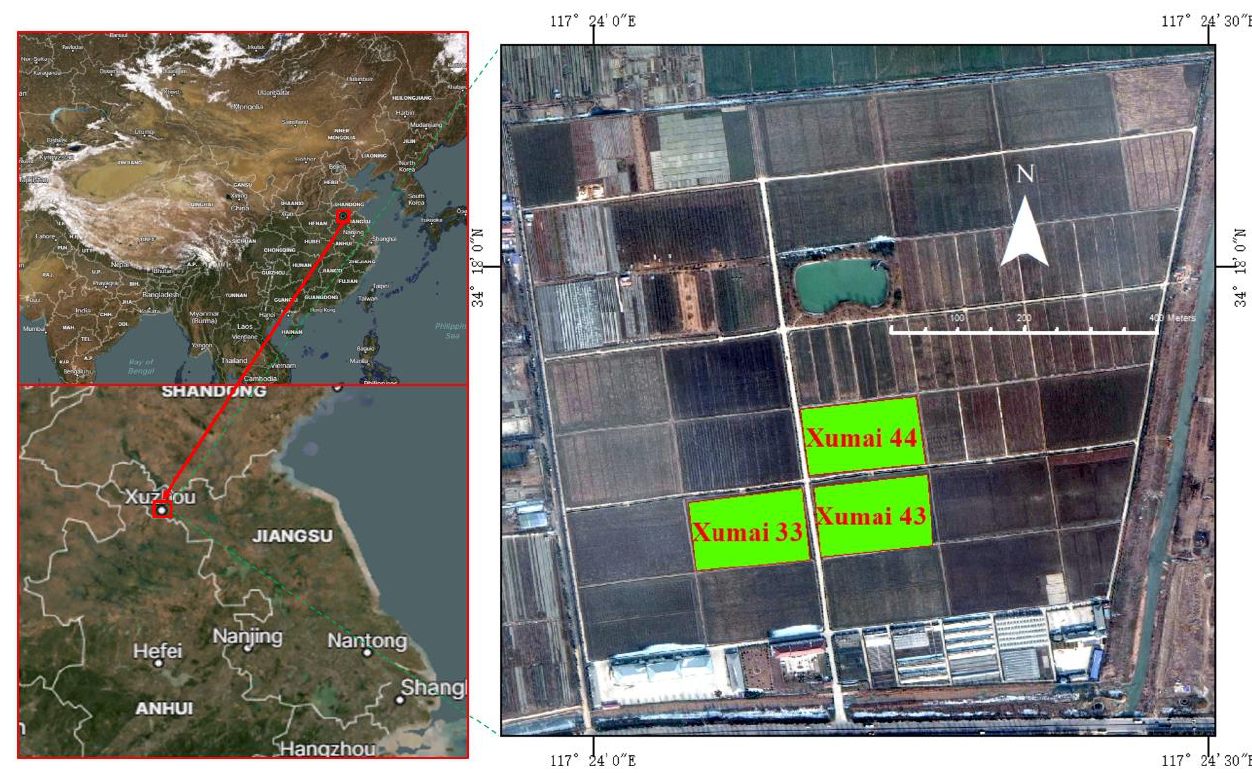
Figure 1. Location of the study area.